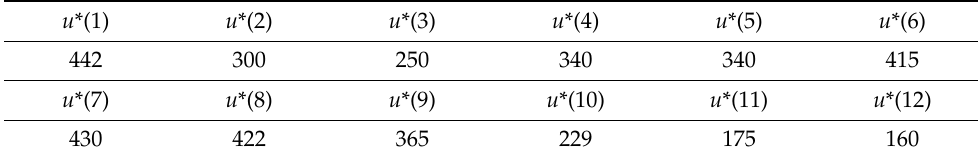
Table 11. Economical production plan.